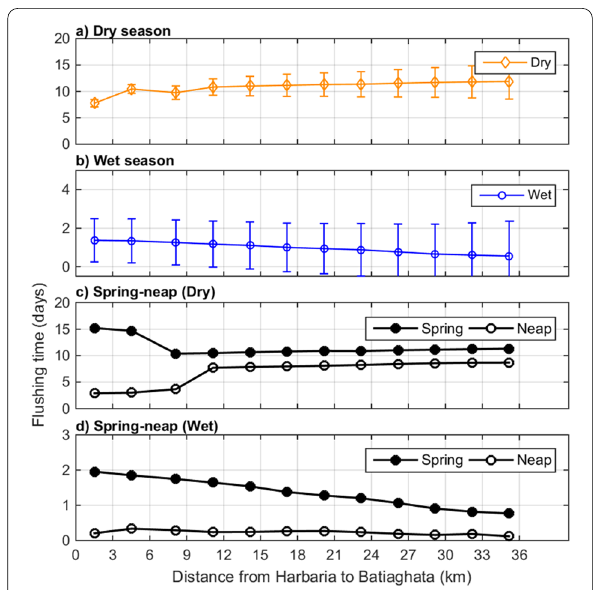
Fig. 8 Spatio‑temporal variation of e‑folding flushing ( FT e ) time for multiple estuarine segments of the Pasur River Estuary during spring and neap tides in the dry and wet